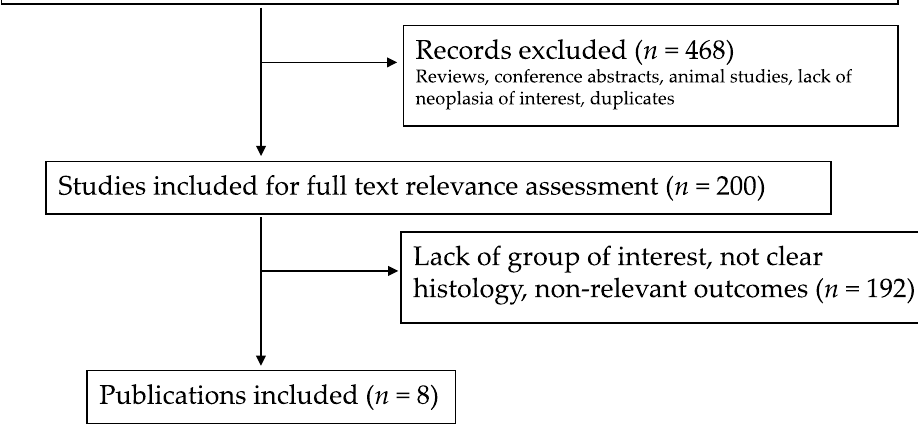
Figure 2. Flow-chart of the literature eligibility assessment process.